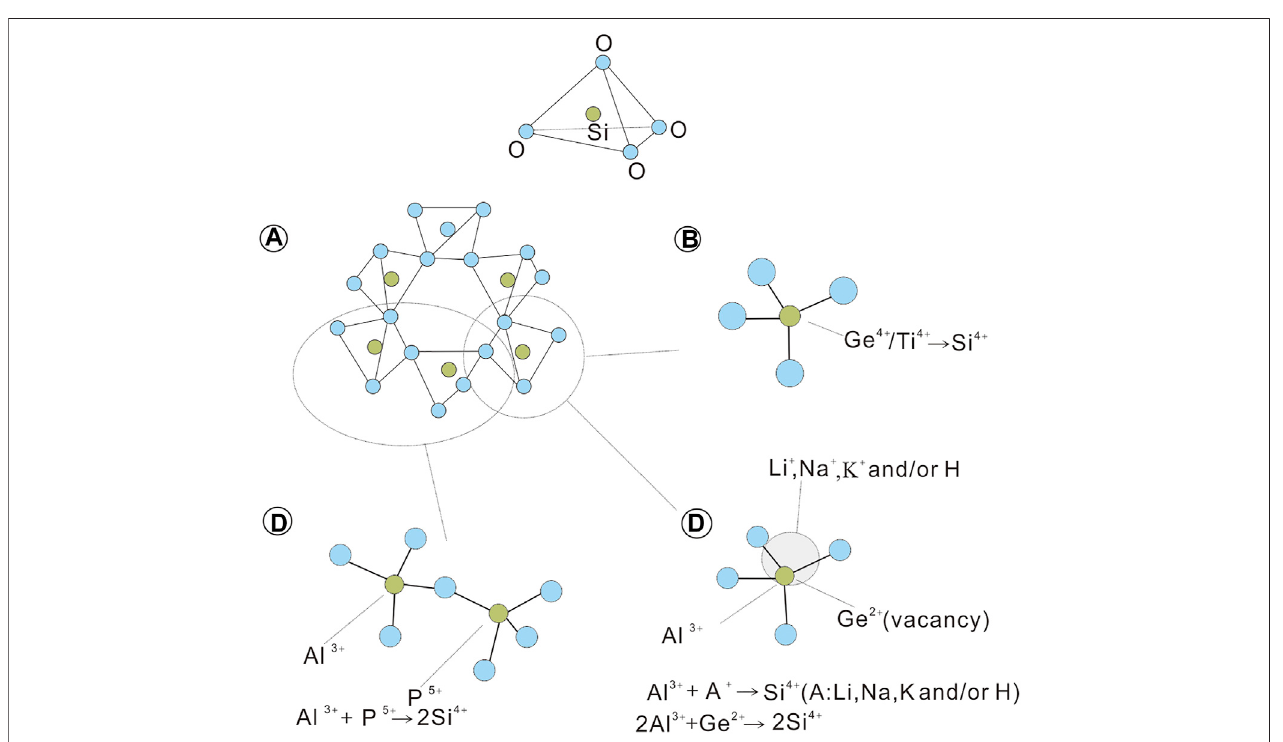
FIGURE 9 | The substitution of trace elements in quartz from the Hongniu-Hongshan deposit (after Larsen et al., 2004).